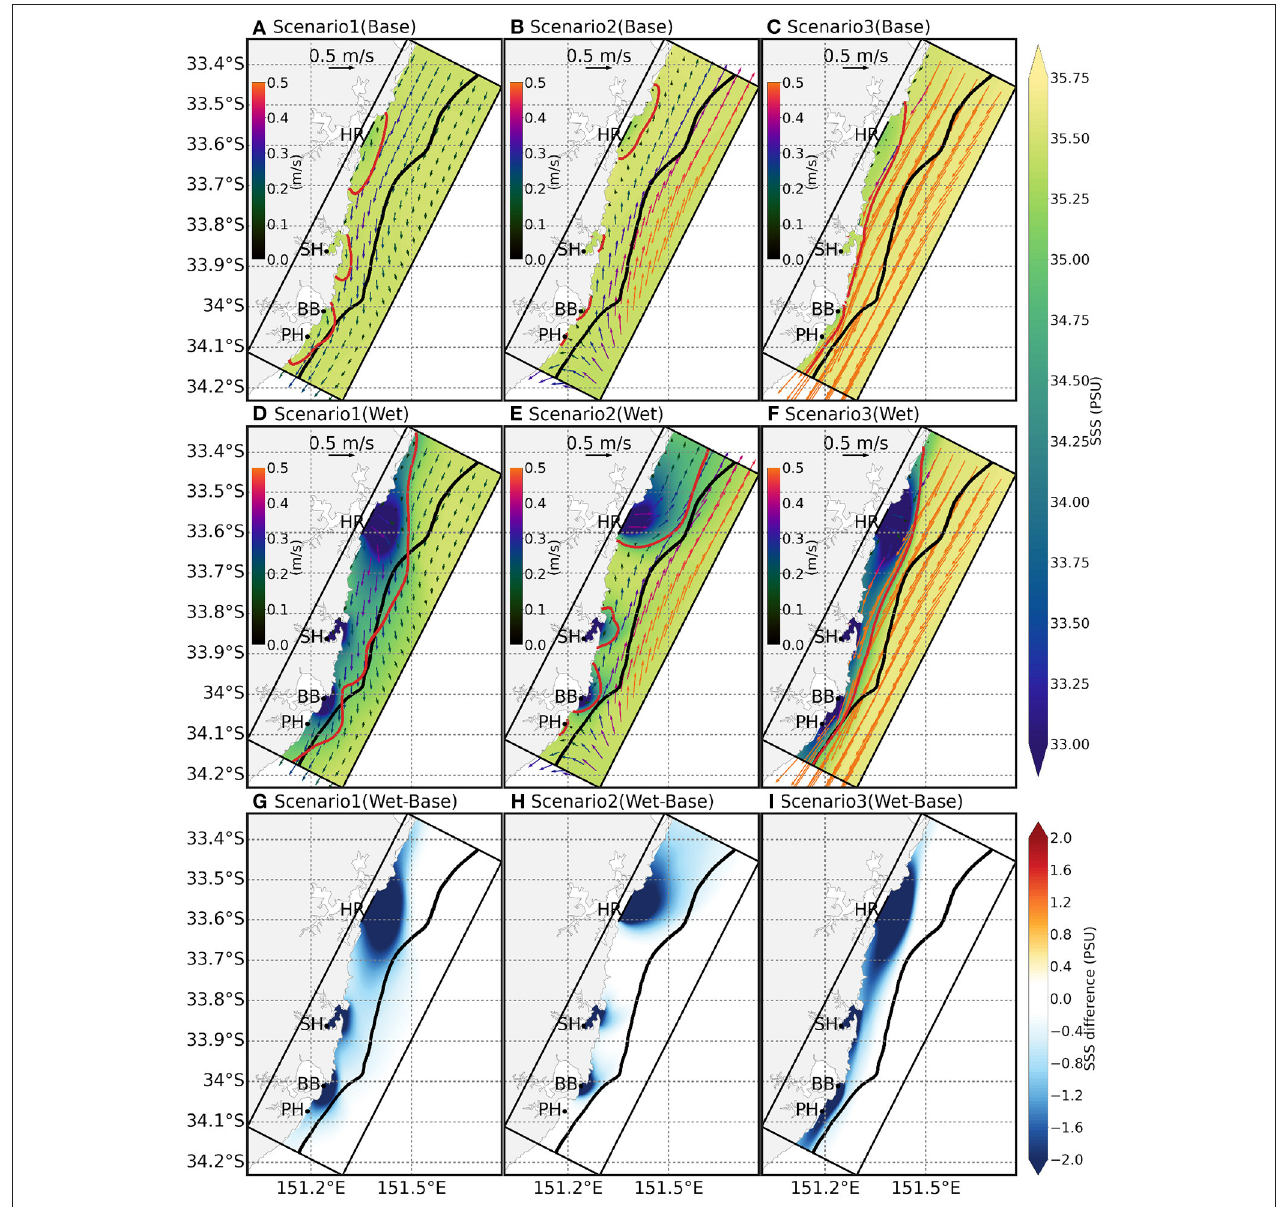
FIGURE 5 | Spatial distributions of SSS averaged over the first 4 days for each EAC scenario and their differences between the wet event and the base case. (A–C) spatial distributions of SSS for EAC scenario 1, EAC scenario 2, and EAC scenario 3 in the base case. The solid black line shows the 100 m isobath, and the red line indicates the contour of 0.15 dye concentration. The vectors show the mean surface velocities. (D–F) Same as (A–C) , but for the wet event. (G–I) Differences of SSS for three EAC scenarios between the wet event (D–F) and the base case (A–C)